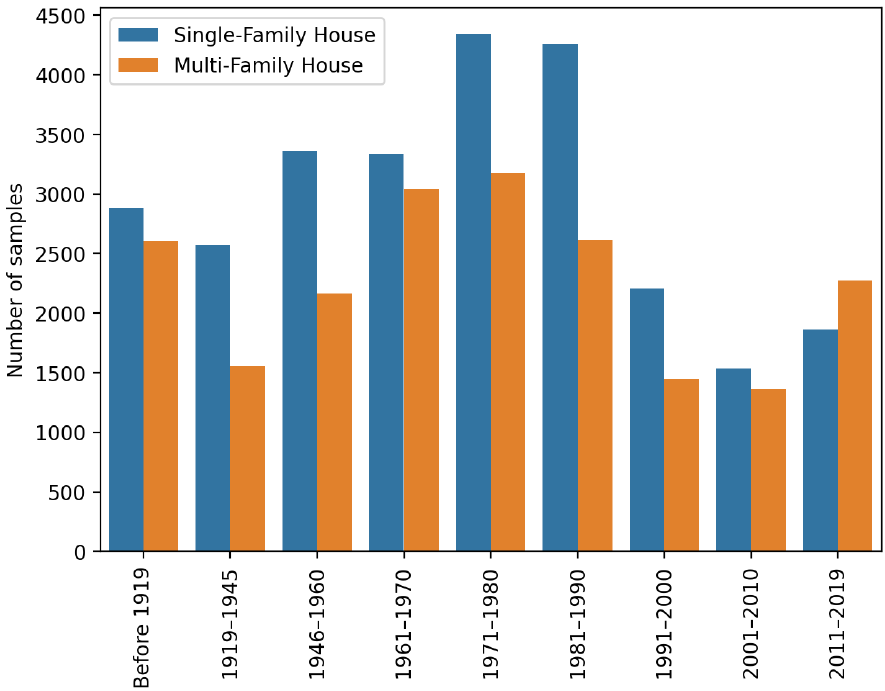
Figure 3. Number of samples for each period of construction.